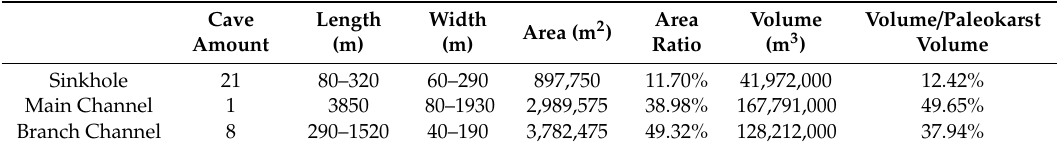
Table 3. Geometrical statistics of paleocaves in the runo ff zone.